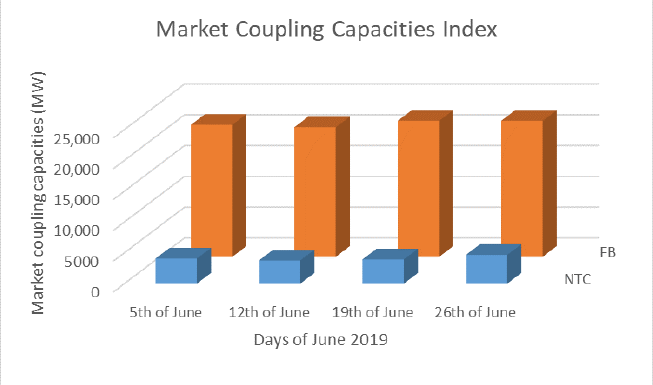
Figure 5. Market coupling capacities index for the five-country scenario via both approaches.